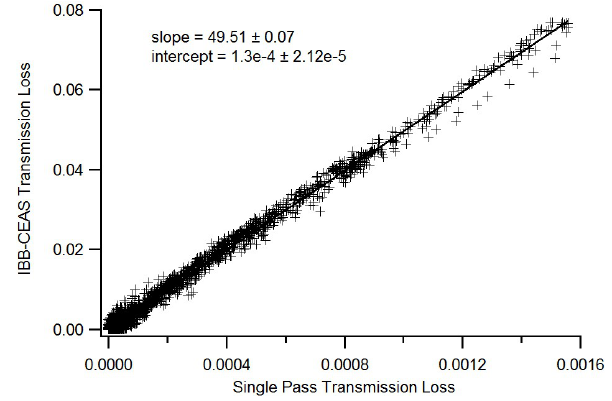
Fig. 5. Measured transmission losses for IBB-CEAS vs. single-pass sample cells with matching ozone concentrations, indicating an enhancement value of 50 × . Scatter is due to noise in the single-pass measurements used in the calculation (see Fig. 4).